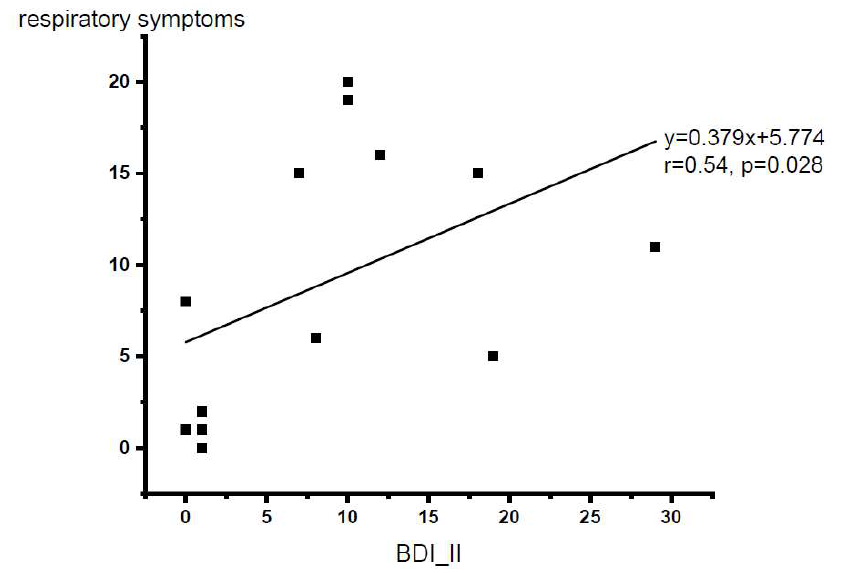
Figure 3. Scatter plot for the BDI-II scores vs. respiratory symptom questionnaire total scores (N = 13 with one outlier excluded). p < 0.05, one-tailed.